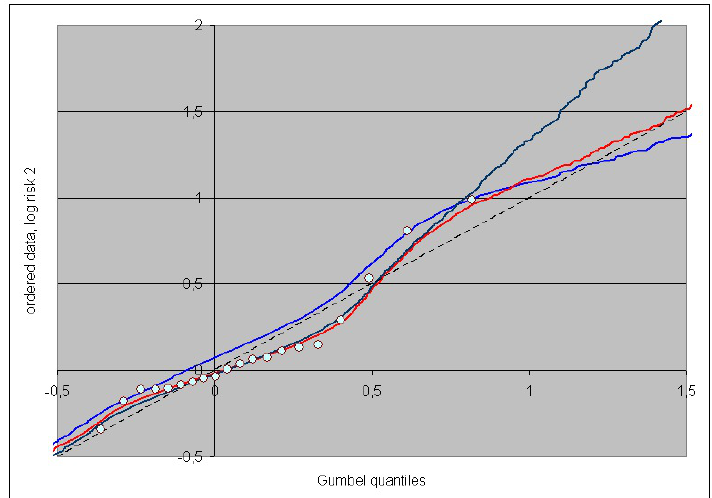
Figure 25. Q-Q-plot for the second risk, ordered log